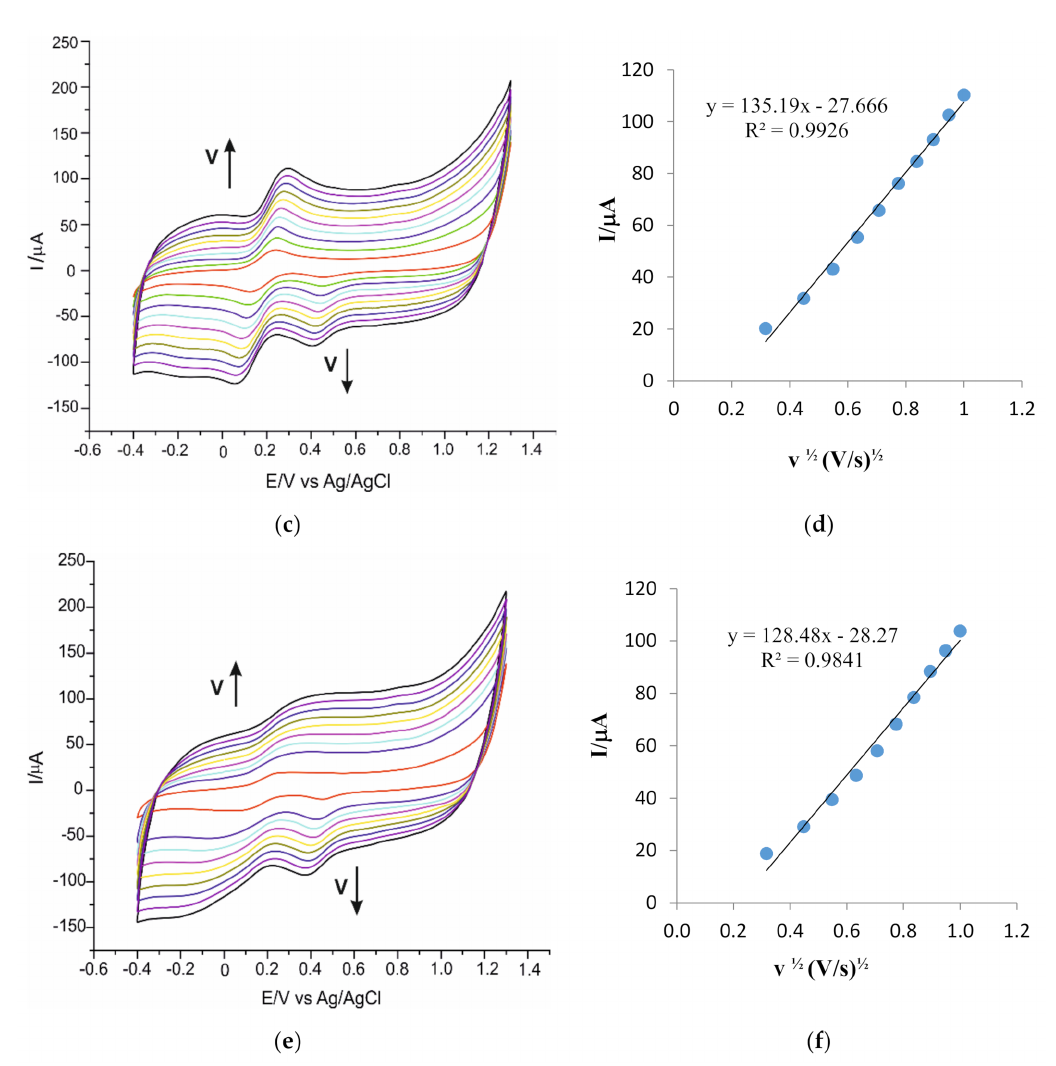
Figure 1. Cyclic voltammograms of CNF / SPE ( a ), CNF-GNP / SPE ( c ), CNF-GNP-Ty / SPE ( e ) immersed in 10 − 3 M K 4 [Fe(CN) 6 ]—10 − 1 M KCl solution registered with scan rates in the range 0.1–1.0 V · s − 1 . The cyclic voltammograms with di ff erent colors correspond to di ff erent scan rates. Plot of Ipc vs. v 1 / 2 for CNF / SPE ( b ), CNF-GNP / SPE ( d ), CNF-GNP-Ty / SPE ( f